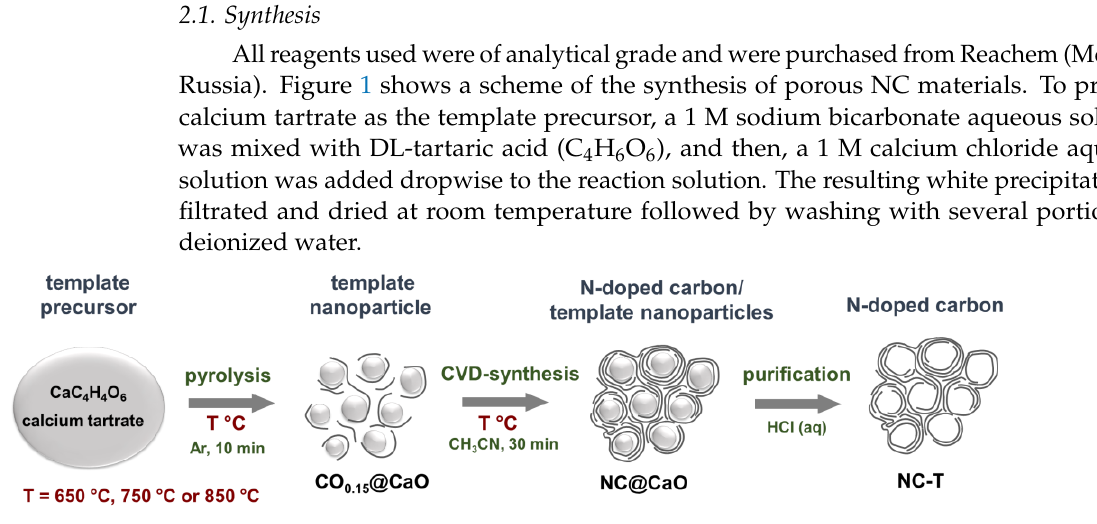
Figure 1. Schematic illustration of synthesis process of N-doped carbon materials at temperatures of 650, 750, and 850 °C.